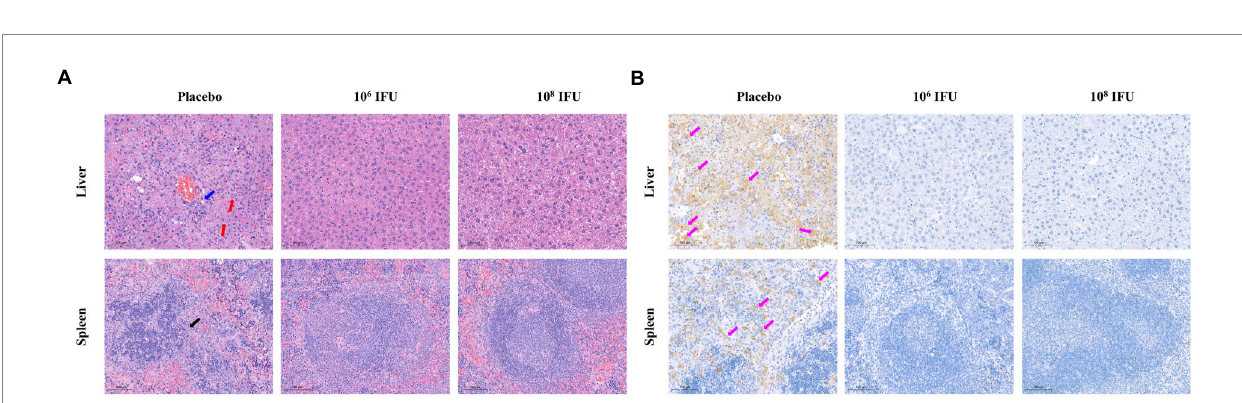
FIGURE 6 Representative histopathology and immunohistochemistry of livers and spleens in RVFV-infected IFN receptor-deficient mice. The livers and spleens from the placebo group (at the time of death) and vaccine-immunized groups (14 days after challenge) were collected and analyzed with histopathological and immunohistochemical assays. (A) Representative histopathology (H&E) of livers and spleens in RVFV-infected mice. Hepatocyte steatosis is indicated by red arrows, hepatocyte necrosis is indicated by blue arrows, and splenic nodules atrophy is indicated by black arrows. Scale bar, 100 μ m. (B) Representative immunohistochemistry (IHC) of liver and spleen tissues with RVFV Gn-specific monoclonal antibodies. Purple arrows indicate RVFV-positive signals. Scale bar, 100 μ